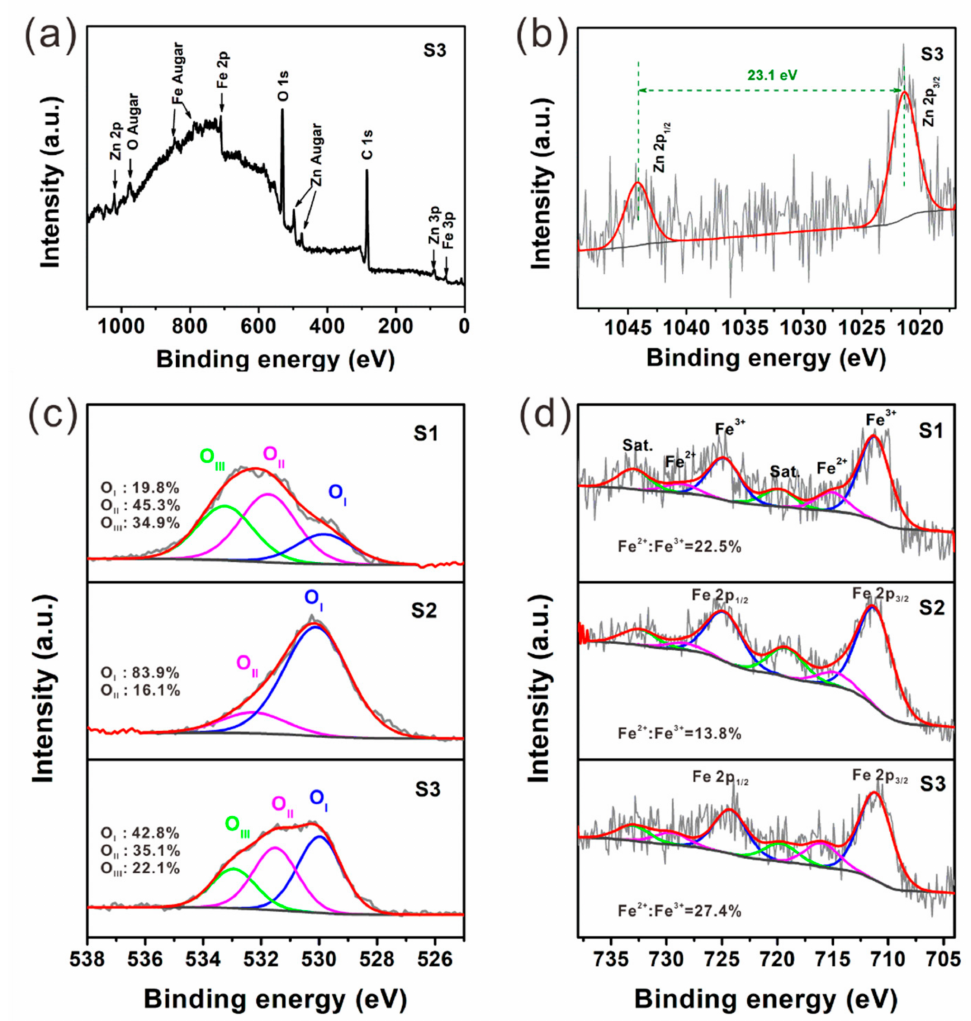
Figure 4. ( a ) Survey spectra and ( b ) Zn 2p spectra of S3; ( c ) O 1s spectra and ( d ) Fe 2p spectra of S1–S3. The atomic content of each element was further calculated from the EDS spectra and the results show that the atomic content of each element in S1 is 14.58%, 16.38%, 38.99% and 30.05% for Zn, Fe, O and C, respectively. The atomic ratio of Zn to Fe is about 0.89, which is higher than the stoichiometric ratio of Zn to Fe in ZnFe 2 O 4 (which is 0.5). The previous analysis of XRD, Raman and PL results shows that S1 is composited of ZnFe 2 O 4 , ZnO, and carbon. Combined with the results of EDS spectra, the content ratio of ZnO to ZnFe 2 O 4 in S1 is calculated to be ~0.78, which is ~0.59 and ~0.77 for S2 and S3 (Table 1), respectively. Larger values close to 1 suggests that more ZnFe 2 O 4 /ZnO interfaces may exist in S1 and S3 than in S2, and the presence of carbon also enriches the types of interfaces in S1and S3 by forming ZnFe 2 O 4 /C and ZnO/C interfaces. Thus, it can be predicted that stronger interfacial polarizations and relaxations may occur in S1 and S3 under alternating electromagnetic